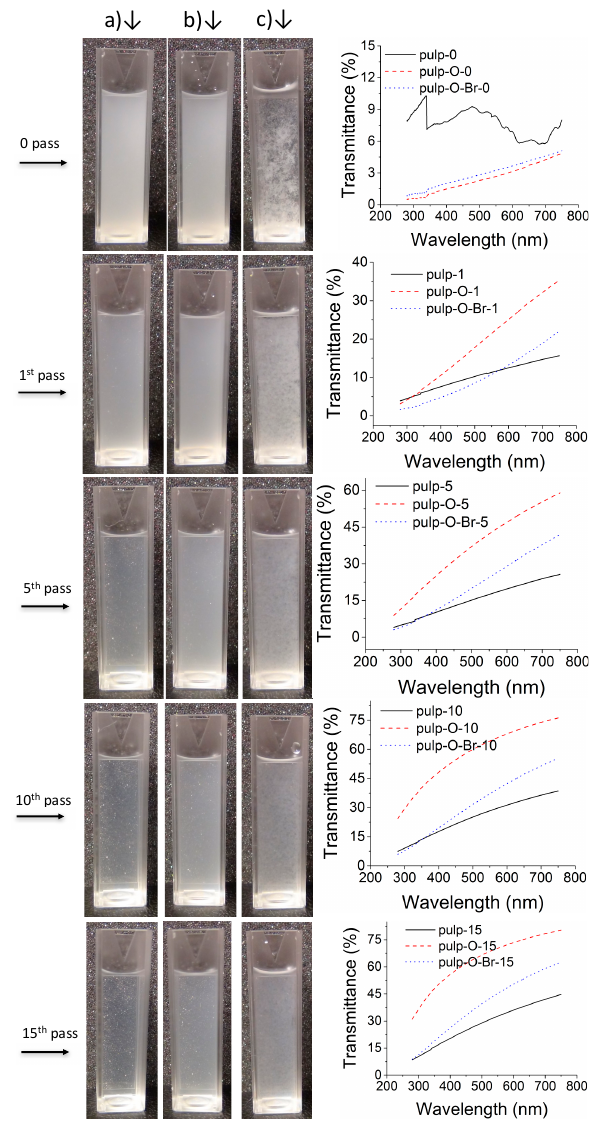
Figure 1. Photographs of dispersions (0.1%, w / v ) of ( a ) pulp-O; ( b ) pulp-O-Br; and ( c ) pulp after different numbers of passes through a homogenizer and the corresponding UV-vis transmittance spectra at a wavelength range from 285 to 750 nm.